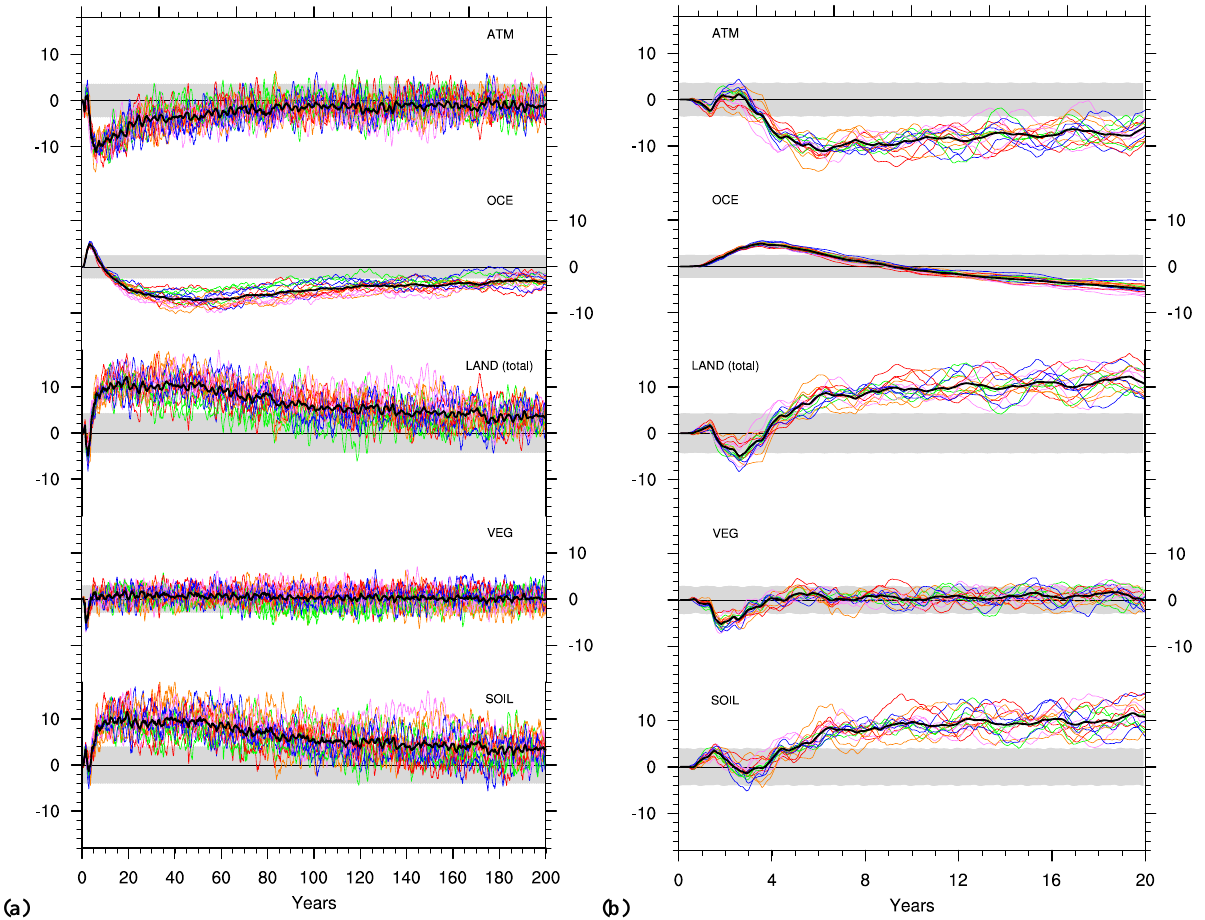
Fig. 9. Time series of annual mean carbon pool anomalies in GtC for (from top to bottom) the atmosphere (ATM), ocean (OCE), land vegetation and soil (LAND), and land vegetation (VEG) and land soil (SOIL) separately. The left column (a) shows the entire 200 years of the experiments, the right column (b) the first 20 years. The thick black line shows the ensemble mean, colours indicate initial conditions as in Fig. 2. The grey bars indicate the ± 2 σ -interval from the control run (see text). The mean carbon pool inventories are: atmosphere 595GtC, ocean 38102GtC, land (total) 3004GtC, vegetation 585GtC, and soil